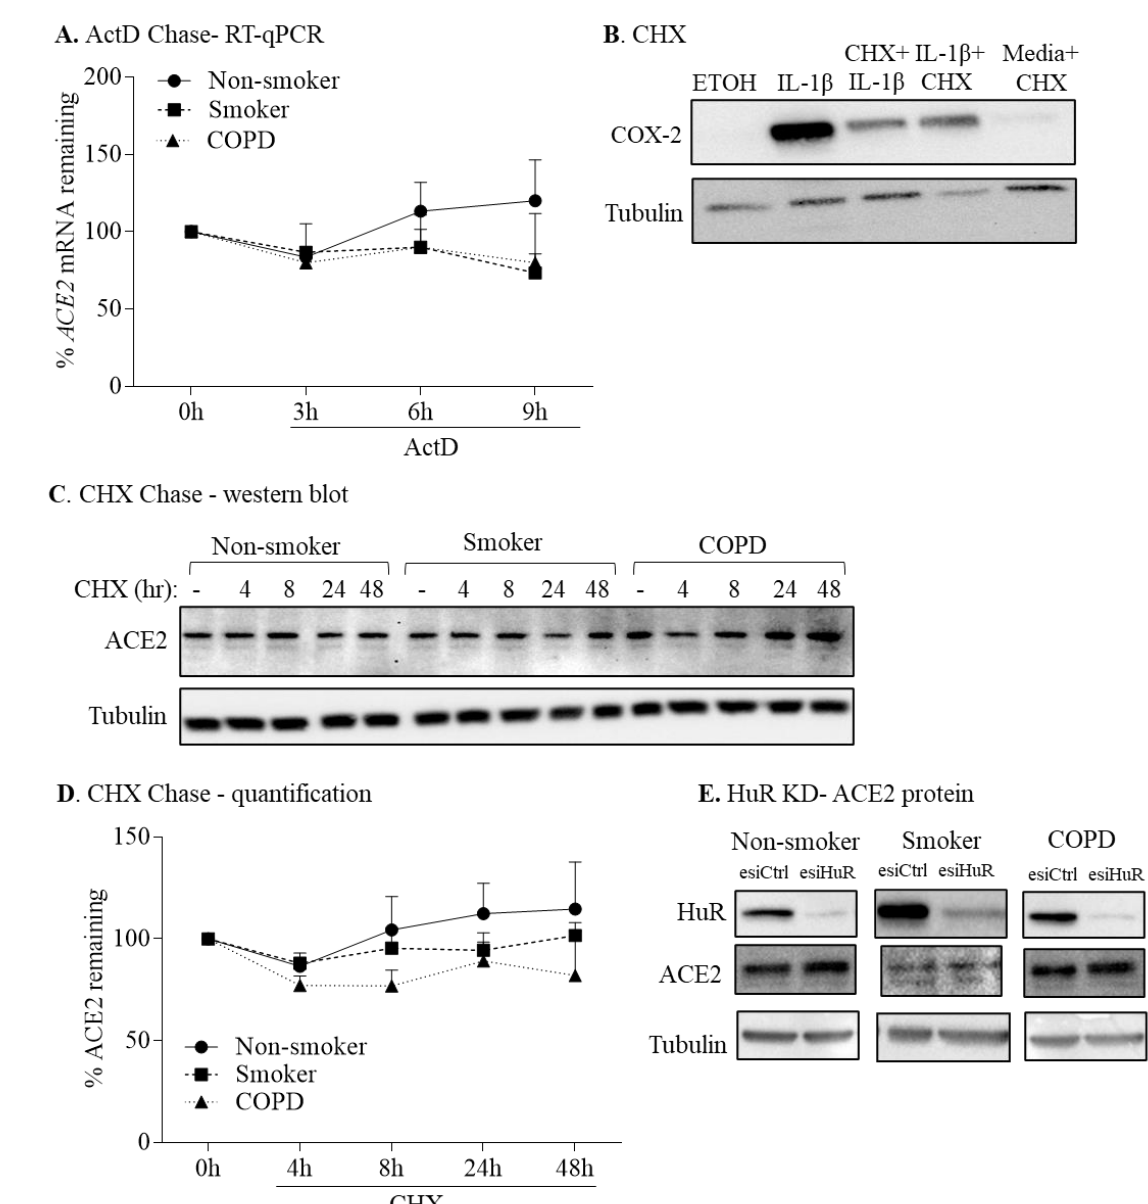
Figure 7. ACE2 mRNA and protein stability are not controlled by HuR. ( A ) ActD Chase—RT-qPCR: HLFs from 3 non-smoker, 3 smoker, and 3 COPD subjects were exposed to ActD (1 µg/ ml) for the indicated time point. ACE2 levels were set to equal 100% after starvation for 18 h (0 h) and are expressed as percentage (%) of ACE2 mRNA remaining. In non-smoker, smoker, and COPD HLFs, ACE2 mRNA was similar after exposure to ActD for 3 h, 6 h, and 9 h compared to time 0. ( B ) CHX: HLFs were exposed to ethanol (control), IL- 1β (1 ng/mL) alone for 24 h, pretreated with CHX (1 μg/ ml) for 1 h followed by IL- 1β for 24 h, or pretreated with IL - 1β for 24 h followed by CHX for 24 h. COX-2 protein expression was reduced by CHX. Representative Western blot is shown. ( C ) CHX Chase—Western blot: HLFs from 3 non-smoker, 3 smoker, and 3 COPD subjects were exposed to CHX (1 µ g/mL) for the indicated time point. Note that there is no change in ACE2 upon CHX treatment. ( D ) CHX chase—quantification: ACE2 levels were set to equal 100% after starvation for 18 h (0 h) and are expressed as percentage (%) of ACE2 remaining. In non-smoker, smoker, and COPD HLFs, ACE2 protein was similar after exposure to CHX for 4 h, 8 h, 24 h, and 48 h compared to time 0. Results are expressed as the mean ± SEM. ( E ) HuR KD-ACE2 protein: HuR knockdown had minimal effect on basal ACE2 protein levels in lung fibroblasts. Representative Western blots are